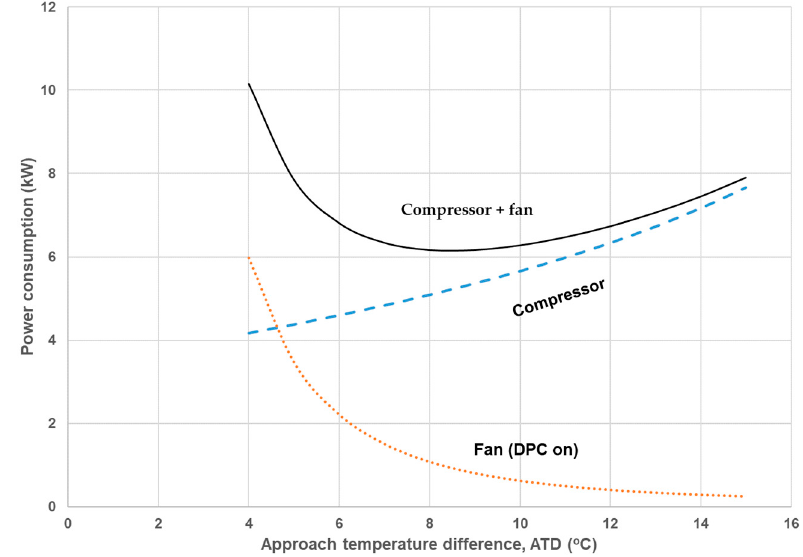
Figure 11. Compressor and fan power consumption vs approach temperature difference (ATD) when the DPC is operating at an evaporator temperature of − 5 °C, condenser inlet air temperature of 14 °C and an evaporator load of 21.5 kW.